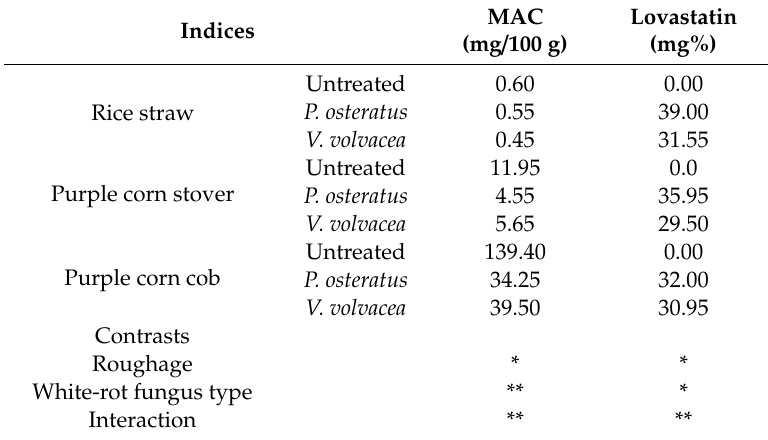
Table 2. Monomeric anthocyanin content (MAC) and lovastatin in rice straw, purple field corn stover and cob. Indices Rice straw